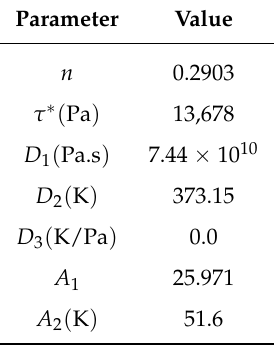
Table 2. Cross-WLF coefficients for GPPS (general purpose polystyrene) Styron 678 from Americas Styrenics